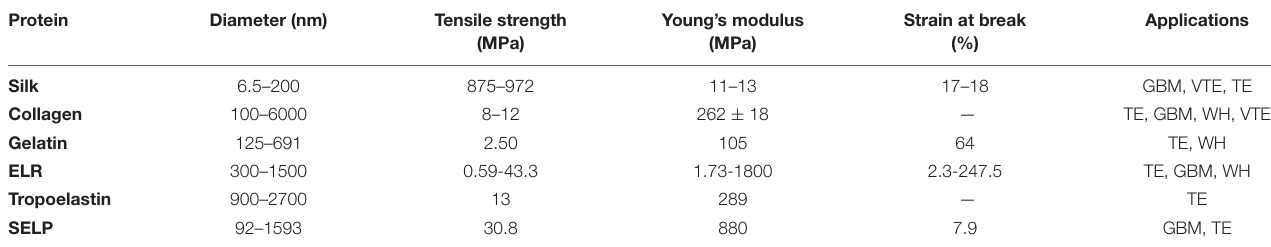
FIGURE 5 | Phalloidin and DAPI staining (green (cytoplasm) and blue (nucleus)) of oriented HFF-1 cells on ELR-click fibers. All channels are merged in panels (A,B) , whereas images (C,D) show the green and blue channels for cytoplasm and nucleus staining, respectively, for a better visualization of the extended morphology of the aligned HFF-1 cells. The inserts represent the orientation data for the cytoplasm and nucleus, respectively. Scale bars: 50 mm. Reproduced with permission from: (doi.org/10.1016/j.actbio.2018.03.027), copyright 2018. TABLE 1 | Properties and applications of different protein-based electrospun